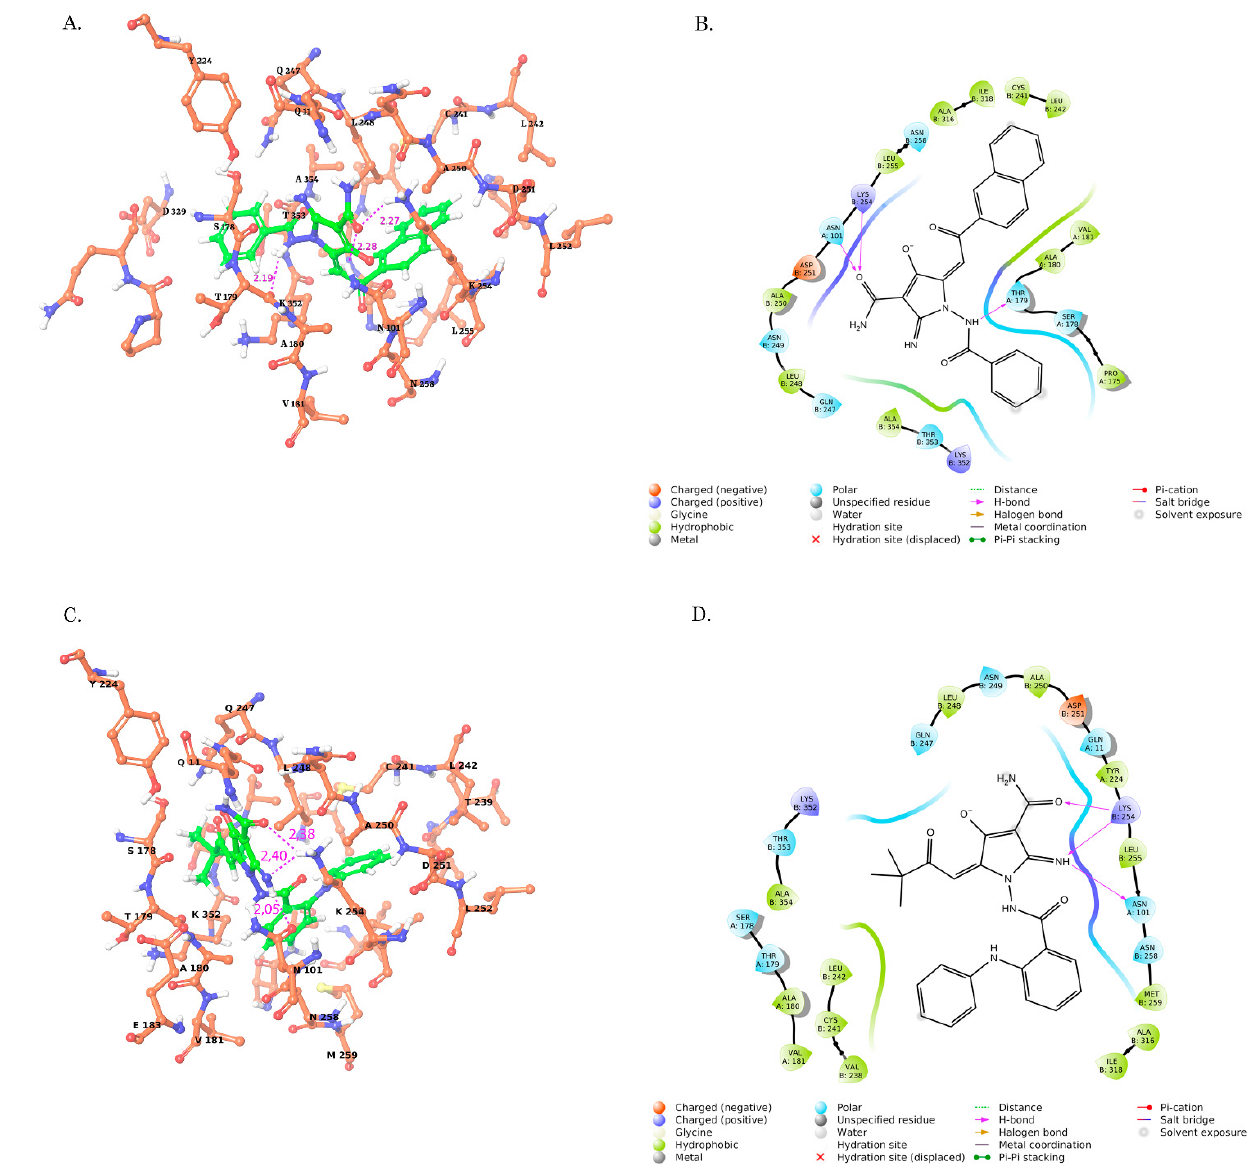
Figure 1. Computer modeling of the CAs binding site on tubulin. ( A , C ) 3D diagram illustrating the proposed binding mode of the interactions of CA-61 ( A ) and CA-84 ( C ), with the tubulin ( B , D ) 2D Ligand interaction diagrams of the CA-61 ( B ) and CA-84 ( D ) with significant amino acid residues.